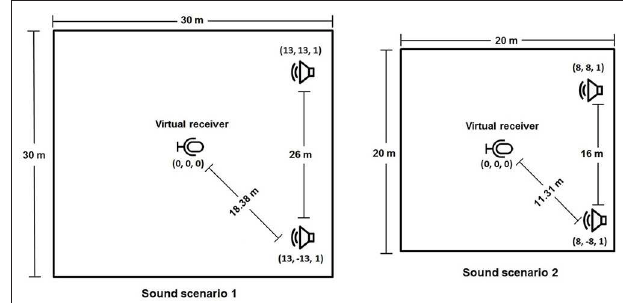
FIGURE 2 | Visualization of the created sounds scenarios. (Left) Sound scenario 1 consisting of large reverberant room (T20 = 0.24 s, T60 = 0.65 s); (Right) Sound scenario 2 consisting of a smaller and less reverberant room (T20 = 0.18 s, T60 = 0.5 s).